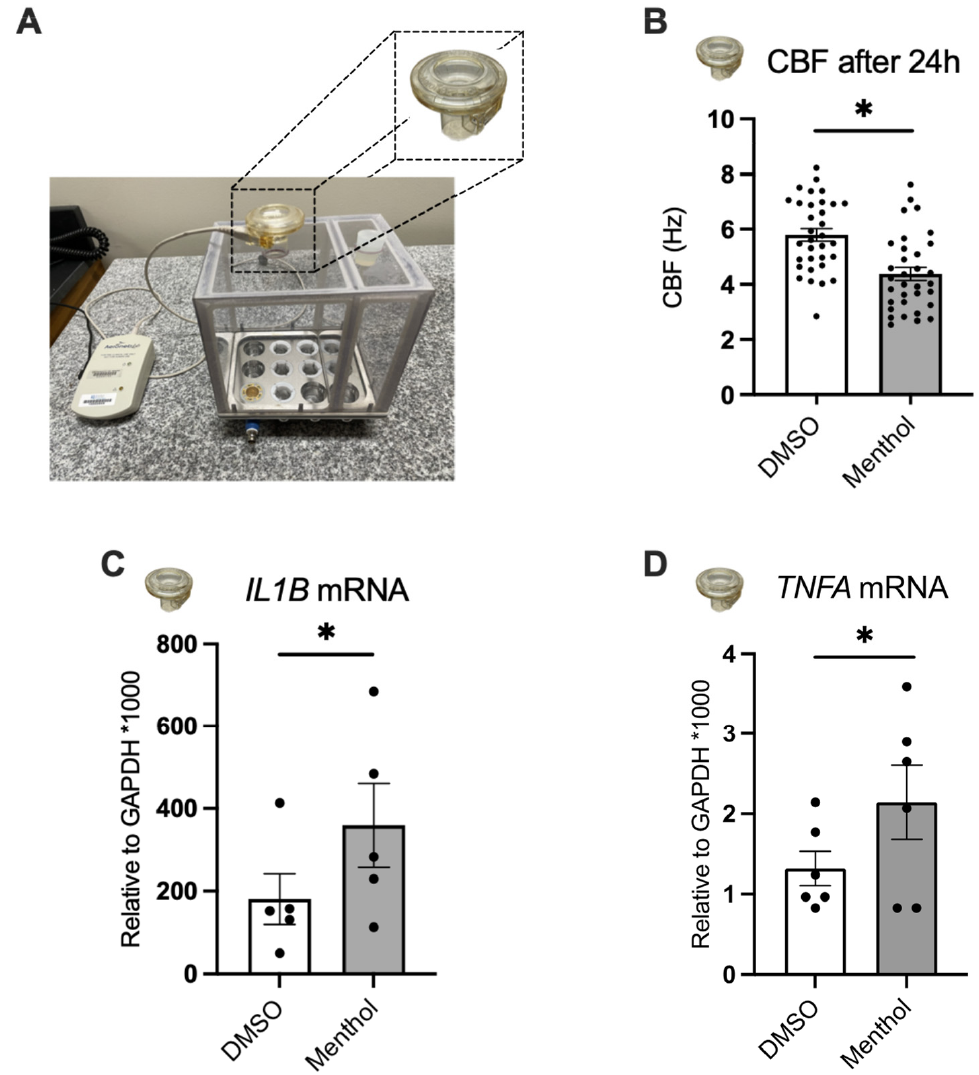
Figure 3. Effects of nebulized menthol on CBF and the expression of inflammatory markers in primary HBEC. All measurements were recorded 24 h after nebulization of DMSO (~0.1% final in the ASL, control) and menthol (~1 mM). ( A ) Cloud system with nebulizer. ( B ) CBF measured 24 h after menthol nebulization and DMSO control. n = 23, 5 lungs. ( C ) IL1B mRNA expression. n = 5, 3 lungs. ( D ) TNFA mRNA expression. n = 6, ≥ 3 lungs. Statistics: Data shown as mean ± SEM. * p < 0.05, mixed model analysis ( B ) or paired t –test ( C , D ) after assessing normality with